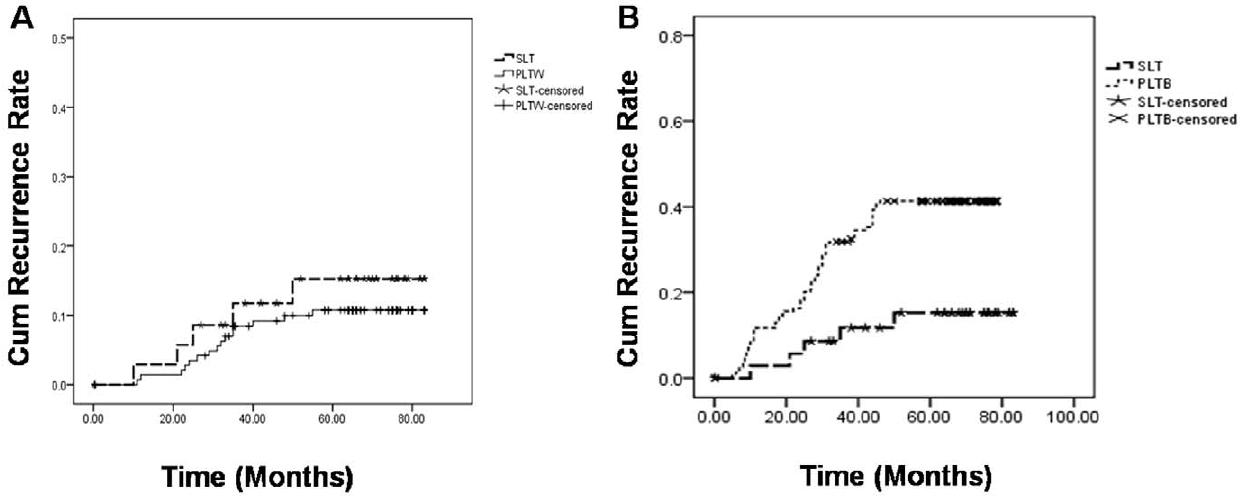
Figure 2. (A) shows the cumulative recurrence rate between SLT group and PLTW group, a Log-Rank test showed P =0.525. (B) shows the cumulative recurrence rate between SLT group and PLTB group, a Log-Rank test showed P =0.006. Abbreviation: SLT salvage liver transplantation, PLTW primary liver transplantation within Milan criteria, PLTB primary liver transplantation beyond Milan criteria.